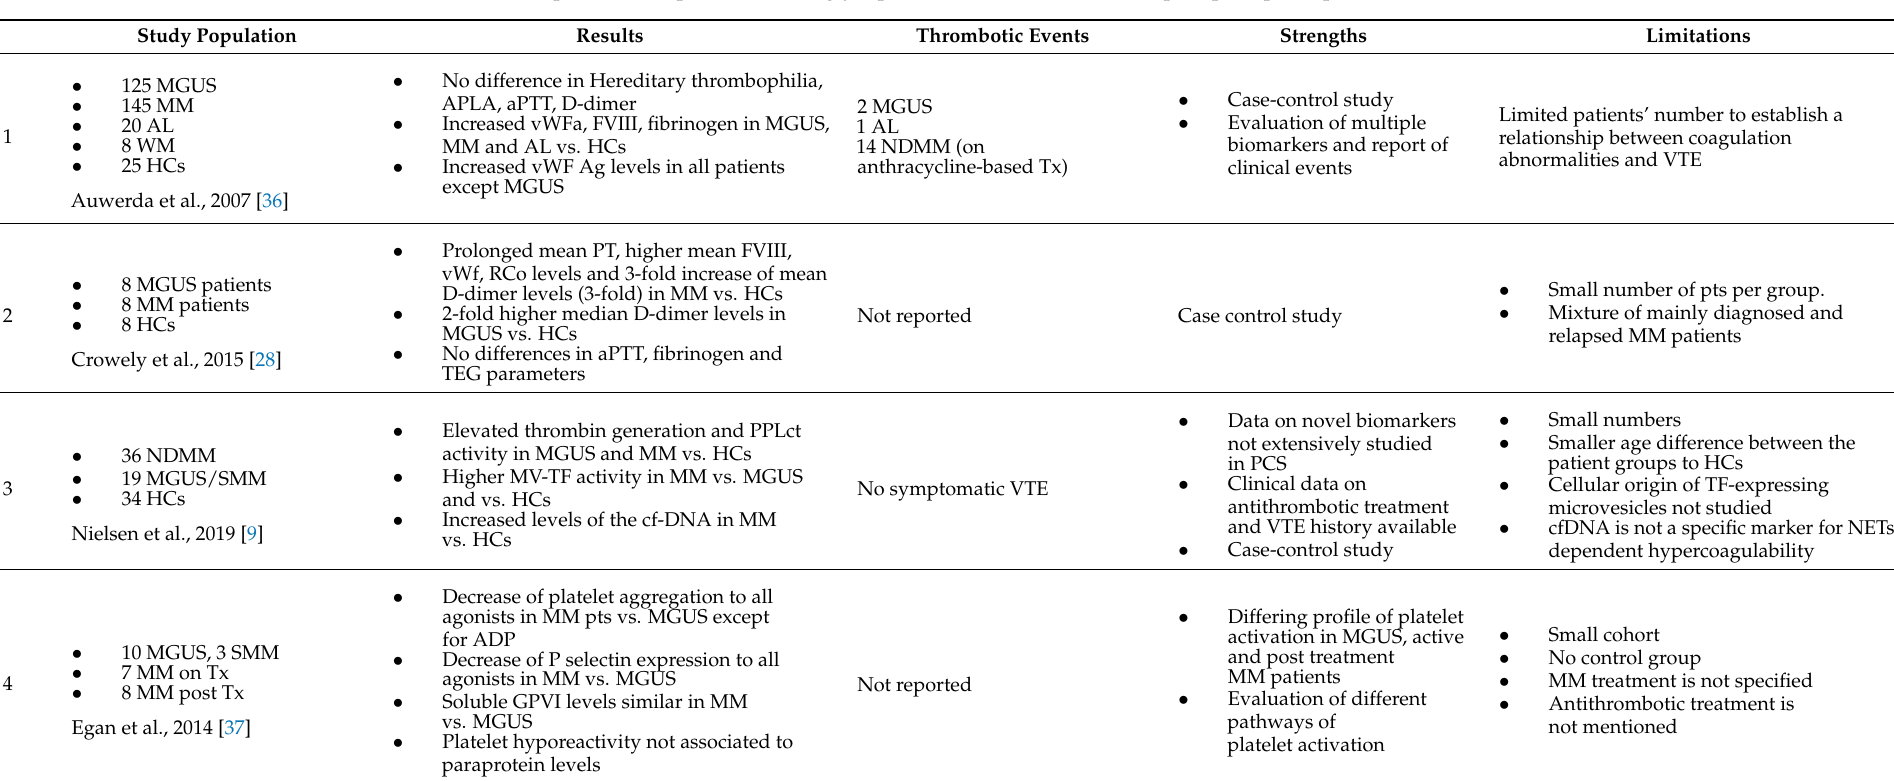
Table 2. Main studies in MGUS, MM, SMM patients reporting biomarkers studied in relation with thrombotic events. Monoclonal gammopathy of undetermined significance (MGUS), healthy controls (HC) and multiple myeloma patients (MM), AL: AL amyloidosis, WM: Waldenstrom’s macroglobulinemia. NS: non-significant, x: no data reported, vWF: von-Willebrand factor, TEG: thromboelastography, TG: thrombin generation, PPL; procoagulant phospholipid, MV TF: microvesicle tissue factor, cf: cell-free, PRP: platelet rich plasma, GPIV: glycoprotein VI levels, APLA: antiphospholipid lupus